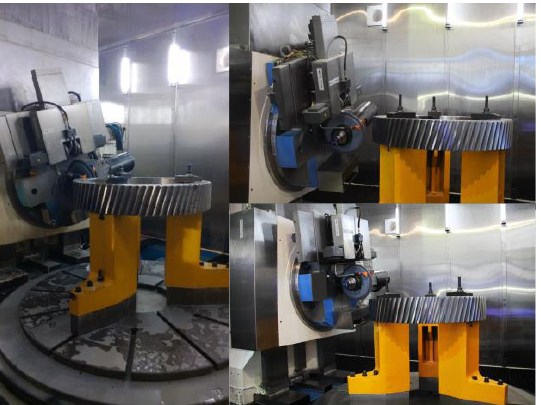
Figure 16. The grinding process of the SKMC-1200W/08 gear profile grinding machine.